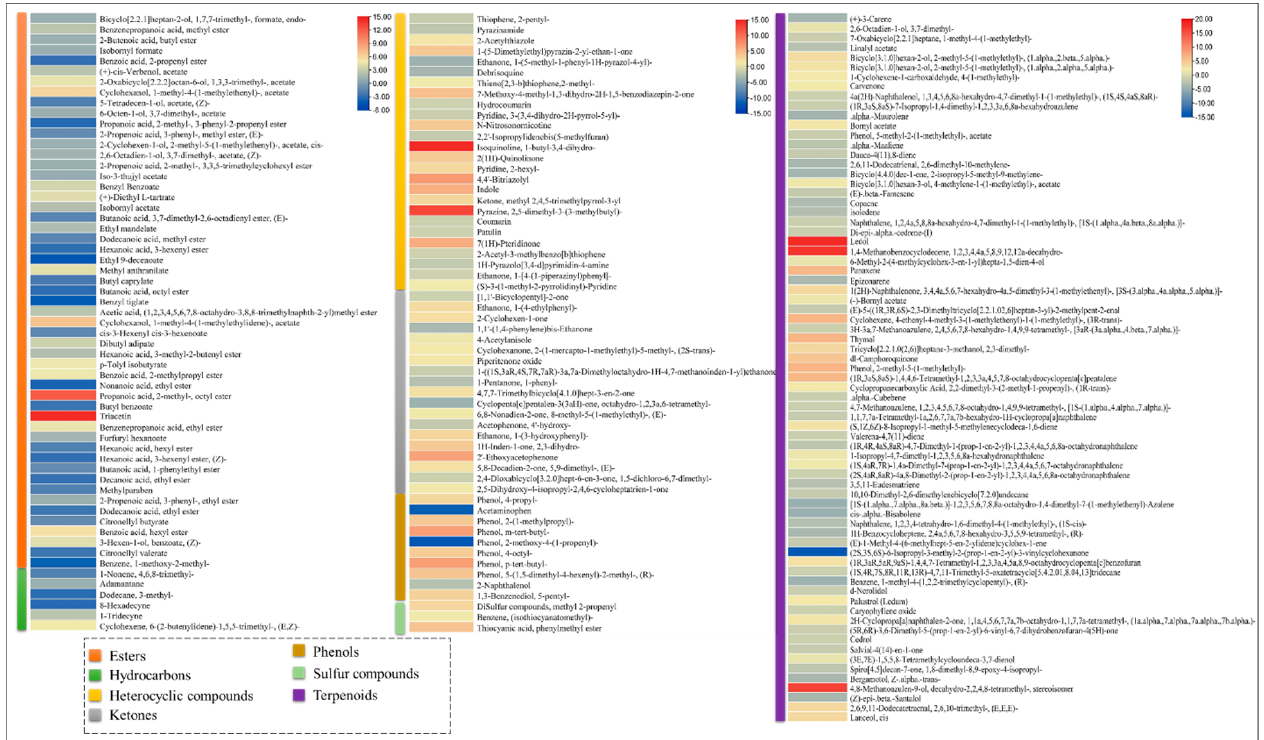
Figure 5. Heatmaps of the log2 foldchange values of esters, hydrocarbons, heterocyclic compounds, ketones, phenols, sulfur compounds, and terpenoids that were differentially accumulated in C. x sinensis peels vs. C. reticulata peels. The colored bars on the right side of the heatmaps represent compound classes.